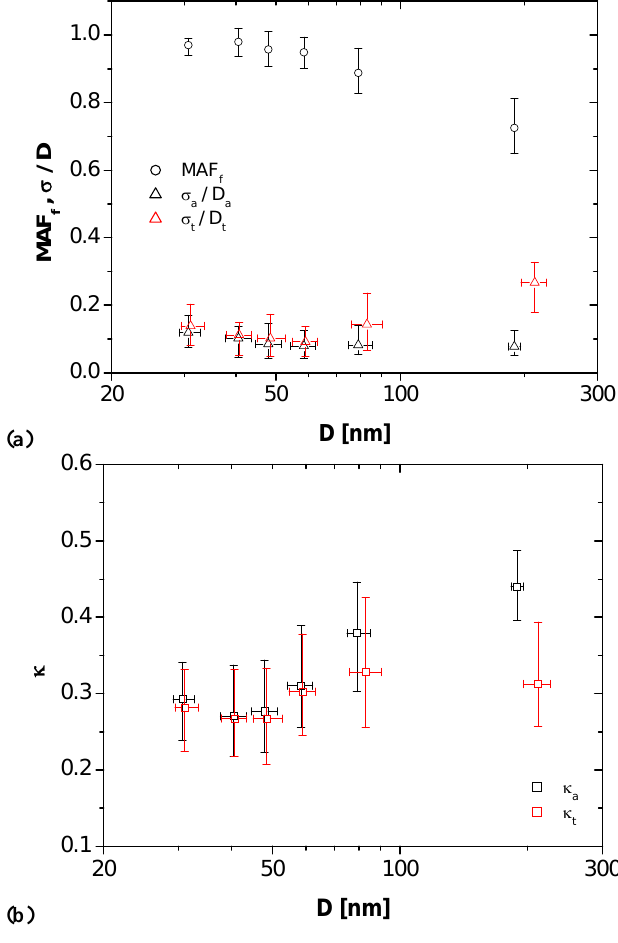
Fig. 4. Characteristic parameters derived from the CCN efficiency spectra averaged over the entire campaign: (a) maximum activated fractions (MAF f ) and heterogeneity parameters ( σ a / D a , σ t /D t ); (b) hygroscopicity parameters ( κ a , κ t ) plotted against the midpoint activation diameter ( D a or D t , respectively). The data points are median values corresponding to a given level of supersaturation, and the error bars extend to lower and upper